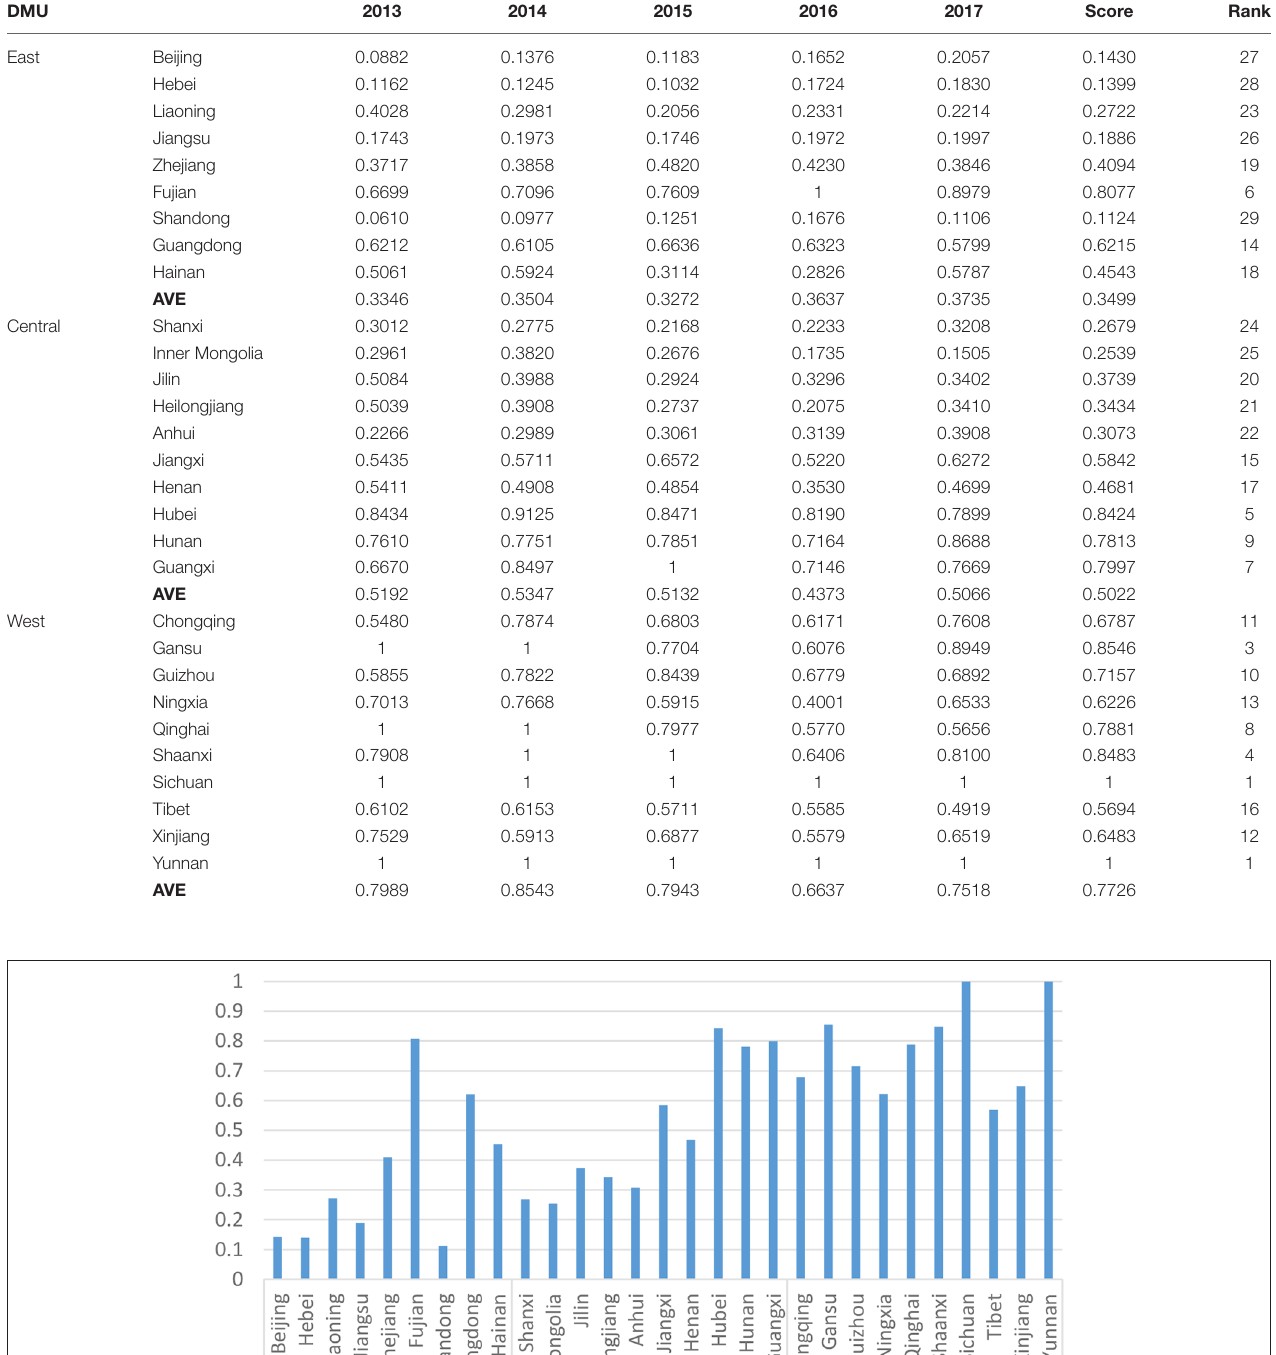
TABLE 3 | The total efficiency score and ranking in different regions. DMU